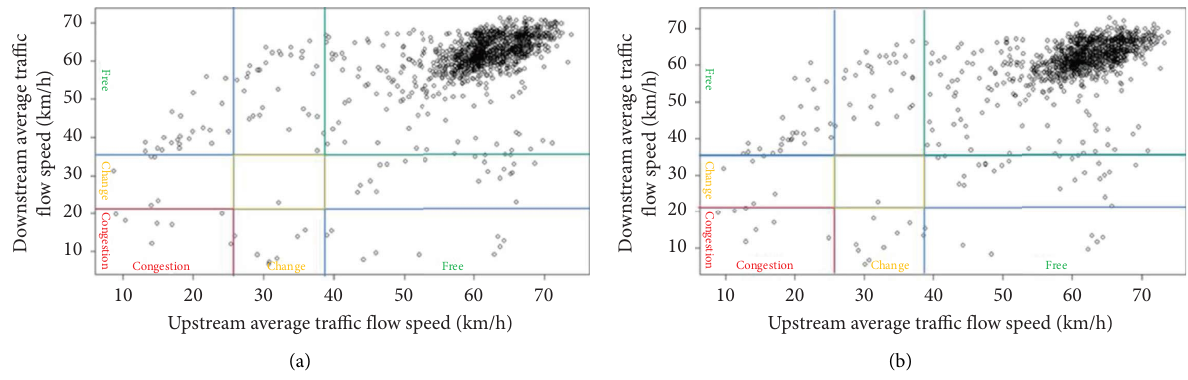
Figure 2: Trafc fow state change in diferent time segments. (a) Time series 1 (5–10min before crash). (b) Time series 2 (10–15min before